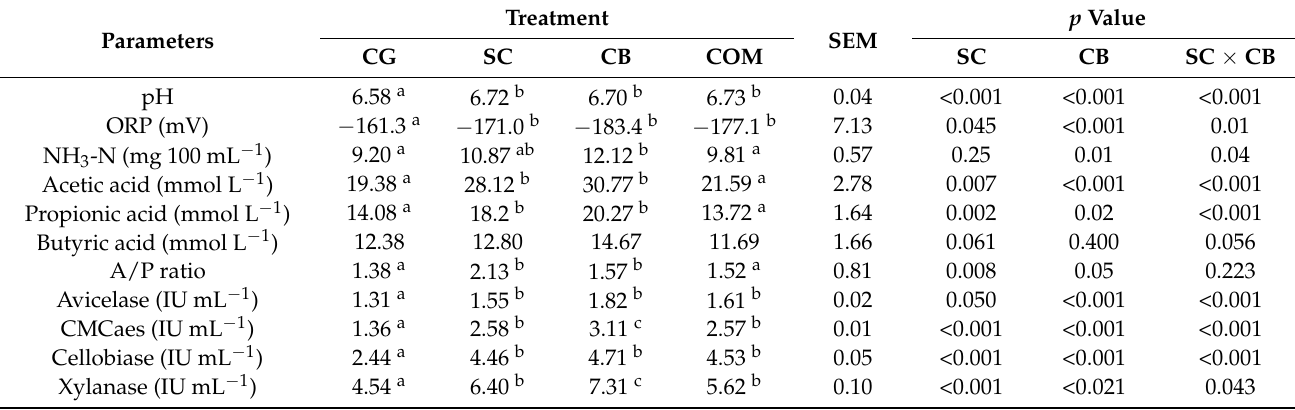
Table 3. Ruminal fermentation parameters and the of ruminal cellulolytic enzyme activities of heat-stressed goats with probiotics supplementation.